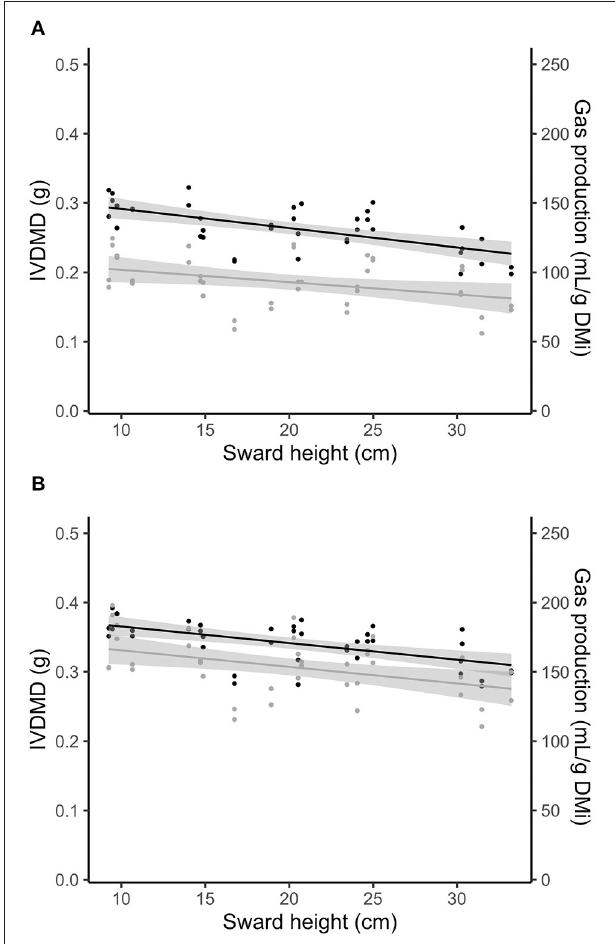
p = 0.004) and then increased at sward heights taller than